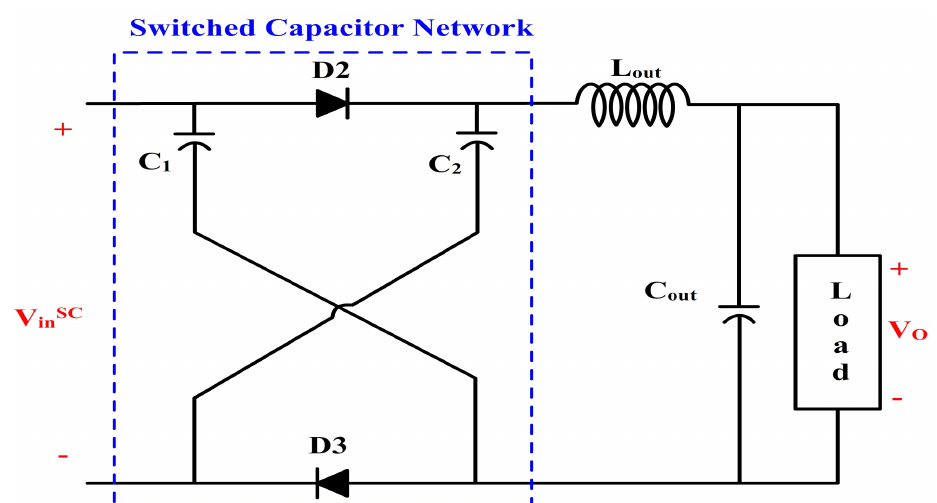
Figure 4. Switched capacitor network of the proposed